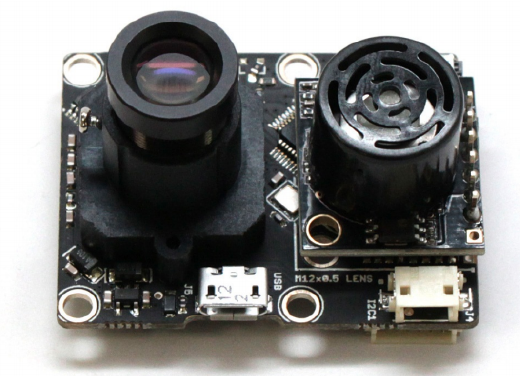
Figure 5. The PX4FLOW optical flow sensor with mounted lens on the left and ultrasonic sensor on the right [93].